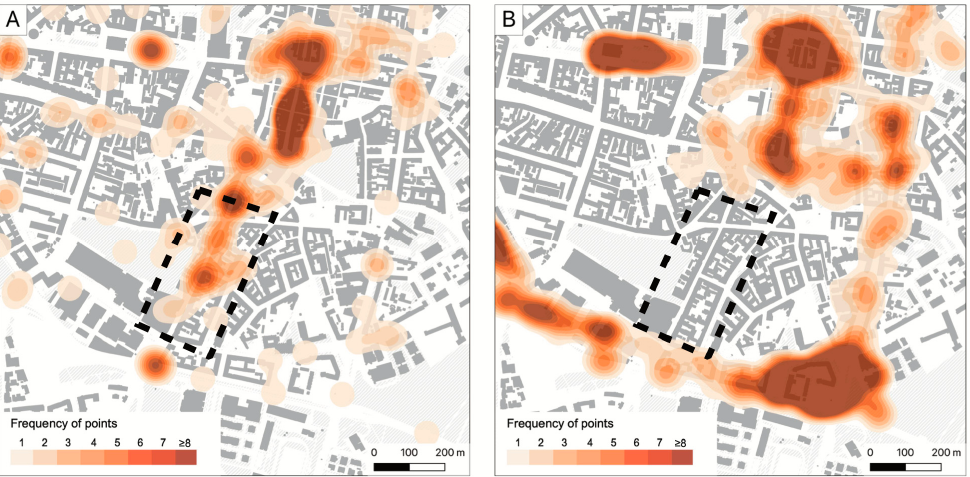
Figure 7. Comparison of places indicated by the group of residents ( A ) and urban planners ( B ) regarding noisy areas—shopping and entertainment area (P ó łwiejska Street). The dashed black line marks the areas of difference. Source of reference data: © OpenStreetMap contributors, see: https://www.openstreetmap.org/copyright (accessed 10 February 2023).